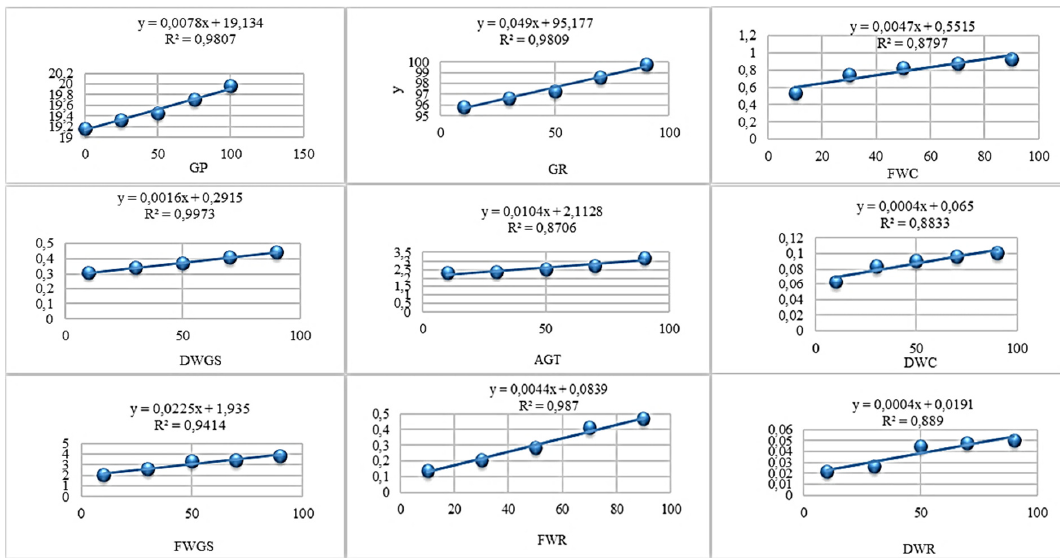
Figure 8. Regression analysis table on averages of number of seeds germinated (number), germination rate (%), average germination time, fresh and dry weight of germinated seeds (g), fresh and dry weight of the coleoptile (g), fresh and dry weight of the radicle (g), the length of the coleoptile and radicle (mm) between each other and salinity concentrations (NaCl), effect of different salt stress percentage of fresh